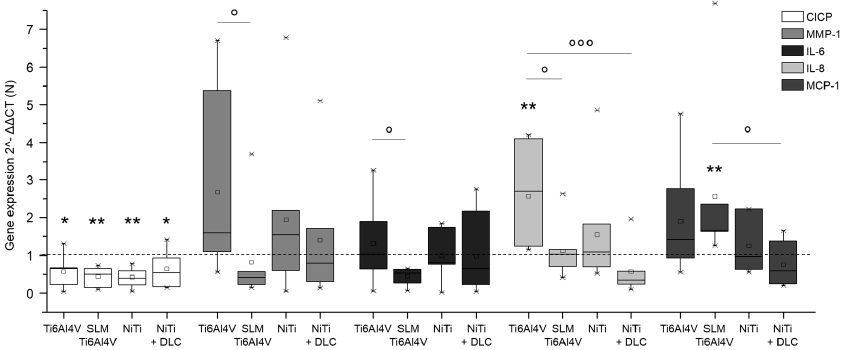
Figure 6. Gene expression (CICP, MMP-1, IL-6, IL-8, and MCP-1) of human osteoblasts ( n = 8) after 96 h of cultivation on several test pellets (forged Ti6Al4V, Ti6Al4V SLM, NiTi, and NiTi + DLC). Boxes denote interquartile ranges, horizontal lines within the boxes denote medians, and whiskers denote minimum and maximum values. Data are normalized to the growth control (=100%, dotted line). For statistical analysis, ANOVA was conducted. A p -value < 0.05 was considered statistically significant. Comparison to respective growth control: * p < 0.05, ** p < 0.01. Comparison between several test pellets: ◦ p < 0.05, ◦◦◦ p ≤